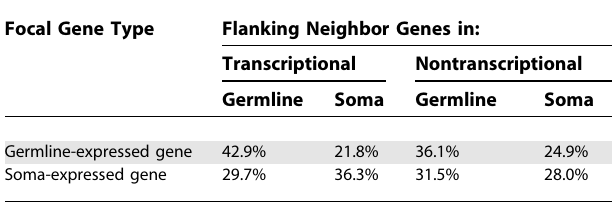
Table 2. Gene Clustering in Transcriptional and Nontranscrip- tional Territories Focal Gene Type